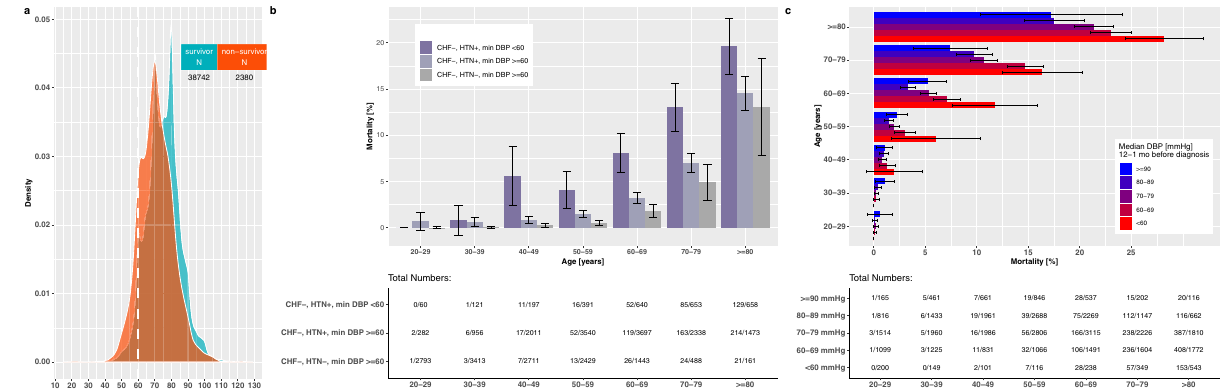
Fig. 1 COVID-19 mortality is associated with prior measurements of abnormally low diastolic blood pressure (DBP). a Distribution of the median diastolic blood pressure measurement in COVID-19 survivors (cyan) versus non-survivors (orange) during days -365 … -31 before the COVID-19 diagnosis date. Threshold for normal range, 60 mmHg, is shown as a white dotted line. b Mortality rates of patients without a recorded history of heart failure (HF-) and either with or without a history of hypertension (HTN + and HTN-, respectively). Cohorts had lowest diastolic blood pressure measurement either at <60 mmHg or > = 60 mmHg on days -365 … -31 before the infection. Patients are distinguished by age groups. 95% con fi dence intervals for the standard error are provided, and indicate the sampling error. c Mortality rates of patients as distinguished by age group and median diastolic blood pressure measurement levels on days -365 … -31 before the infection. 95% con fi dence intervals for the standard error are provided, and indicate the sampling error. For the N = number of patients in each category, see the table inserts in the fi gure